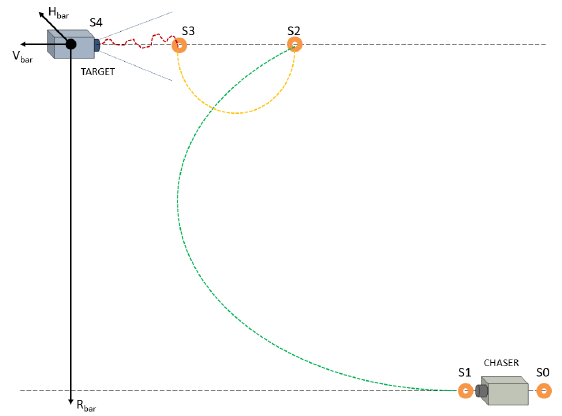
Figure 1. Complete rendezvous and docking maneuver in Hill frame.